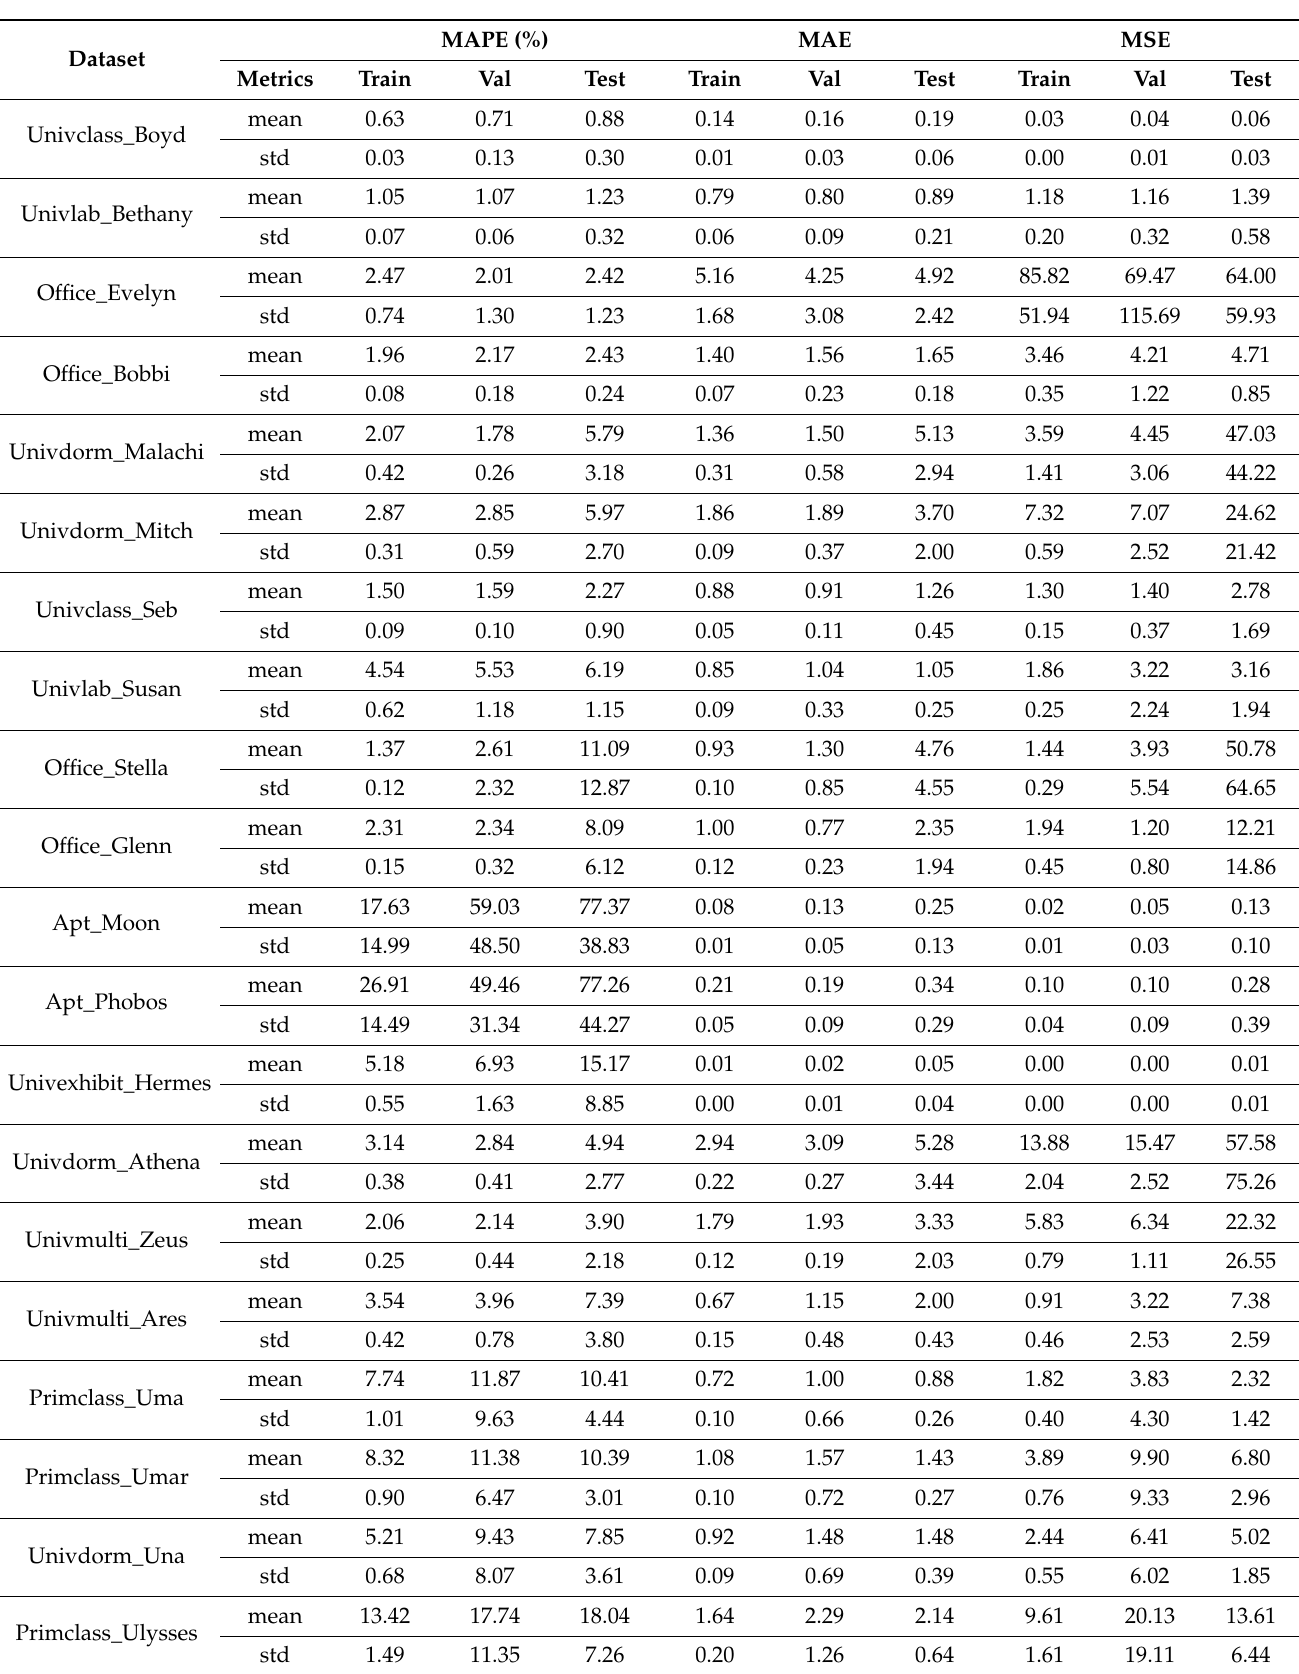
Table 14. The cross-validation result of forecasting using